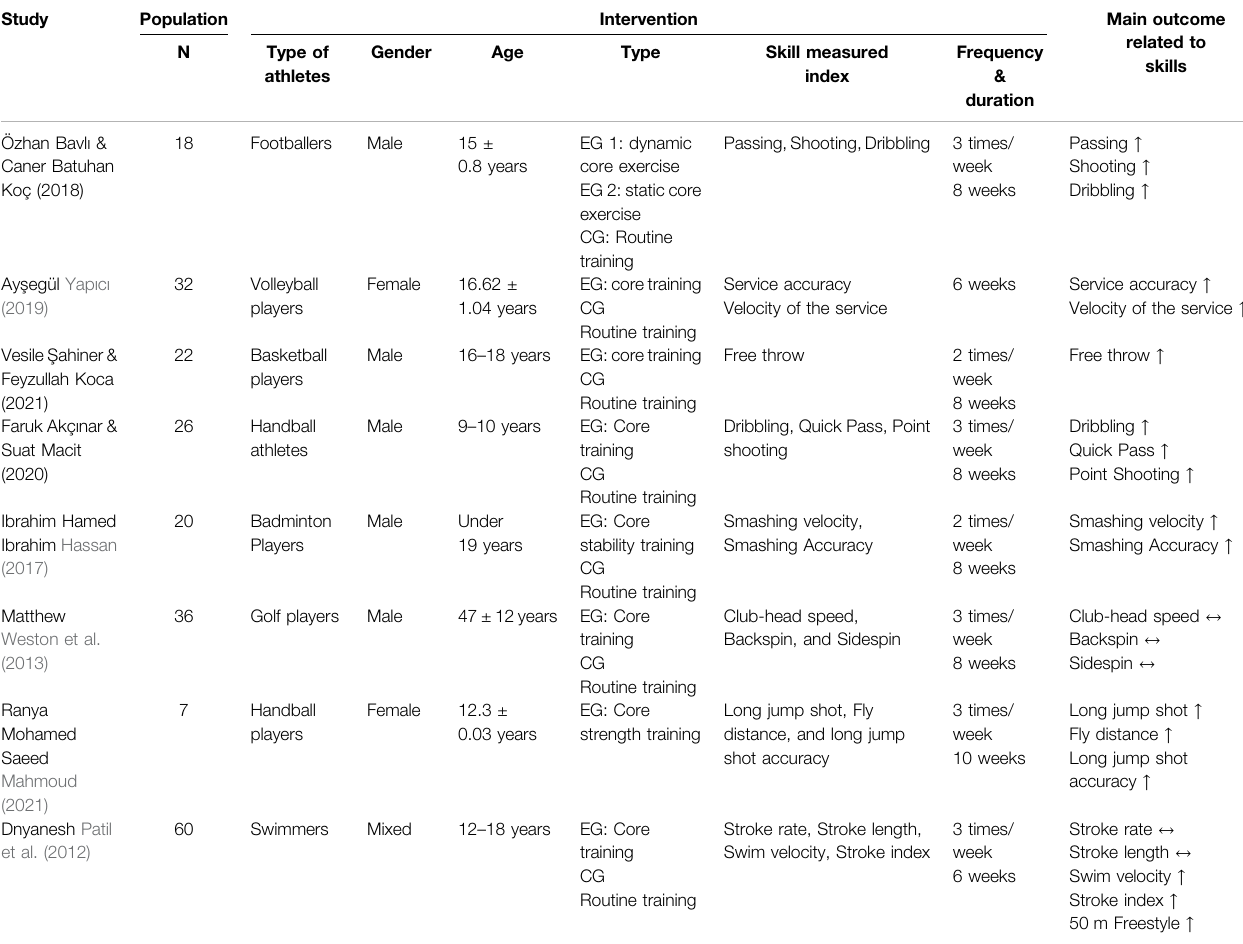
TABLE 4 | The categories of sports.